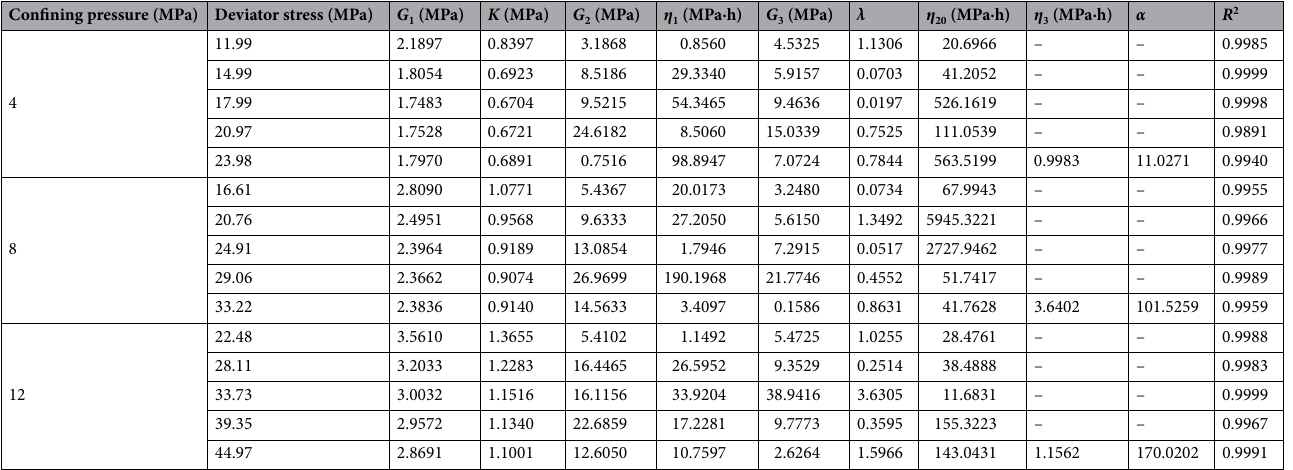
Table 2. Model parameter identification results in the loading